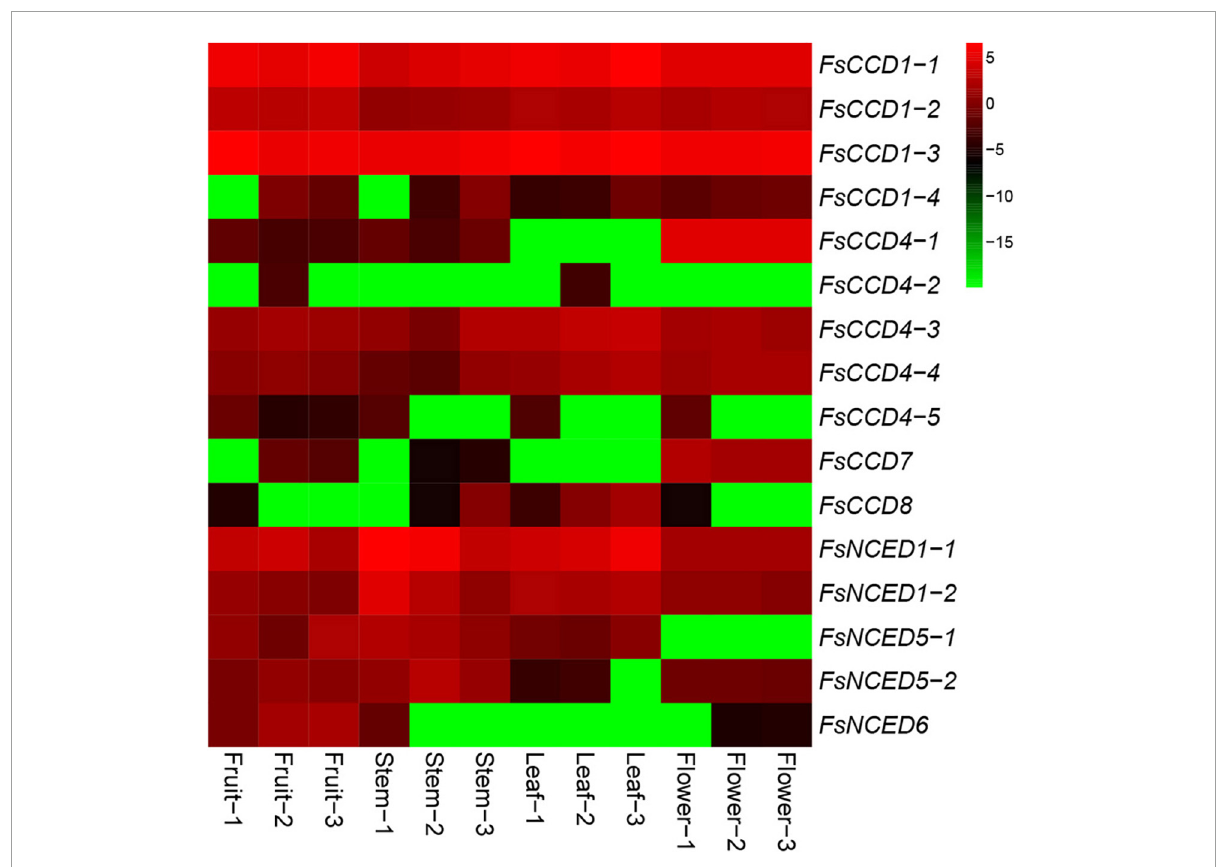
FIGURE8 Heat map of CCD gene expression (Log 2 FPKM) in different tissues of Forsythia suspensa . Fruit-1 to Fruit-3, Stem-1 to Stem-3, Leaf-1 to Leaf-3, and Flower-1 to Flower-3 indicate the three biological replicates from each